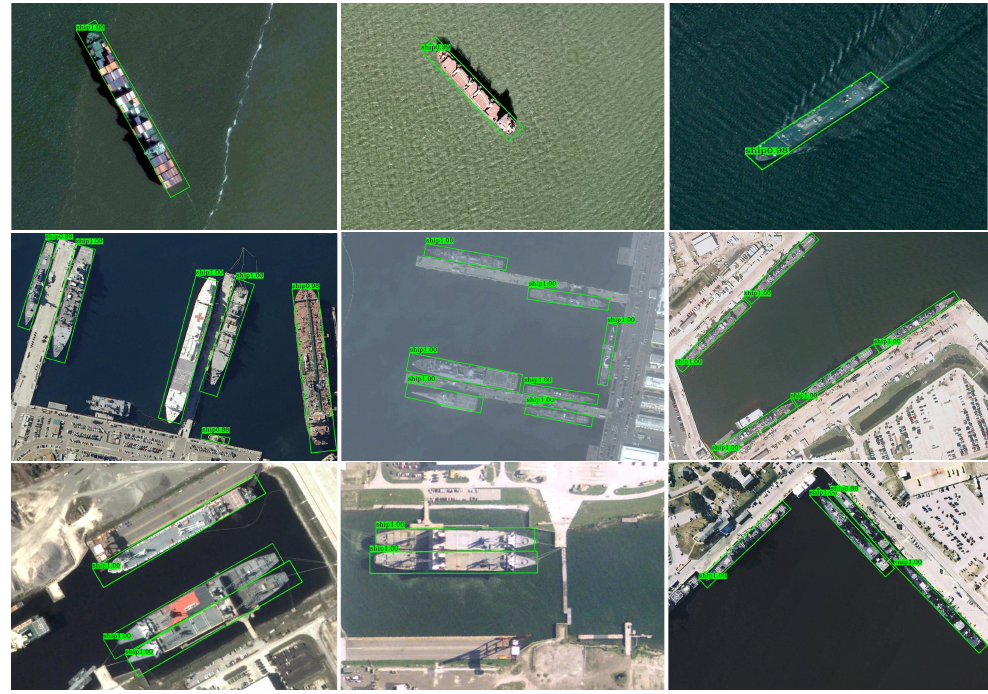
Figure 8. Visualization of some detection results on HRSC2016 dataset. Table 7. Comparisons with high-quality detection performance on HRSC2016 dataset.